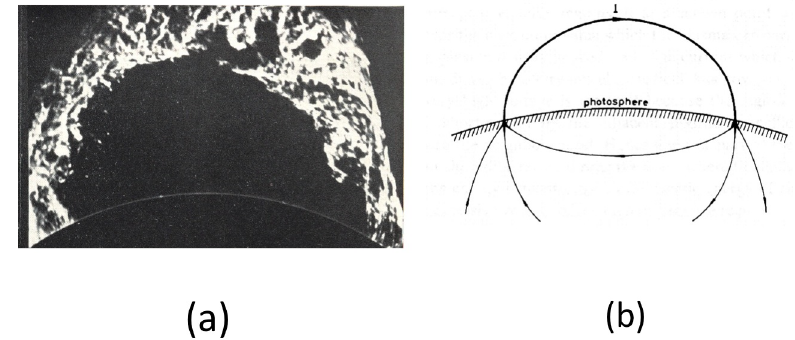
Figure 3. (a) An example of expanding prominences (courtesy of W. O. Roberts, 1970). (b) A current loop for a prominence (Alfvén and Carlqvist, 1967).